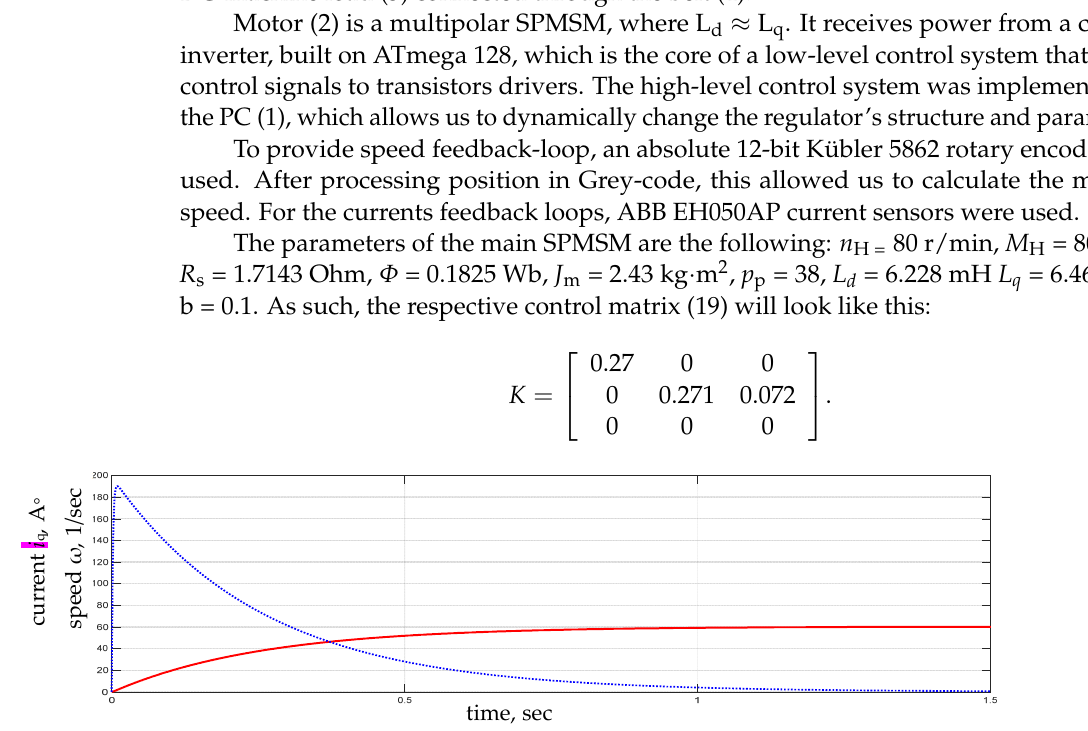
Figure 7. Dependences of current i q (…) and speed of rotation 𝜔 (__) changes in the synthesized PMSM control system.